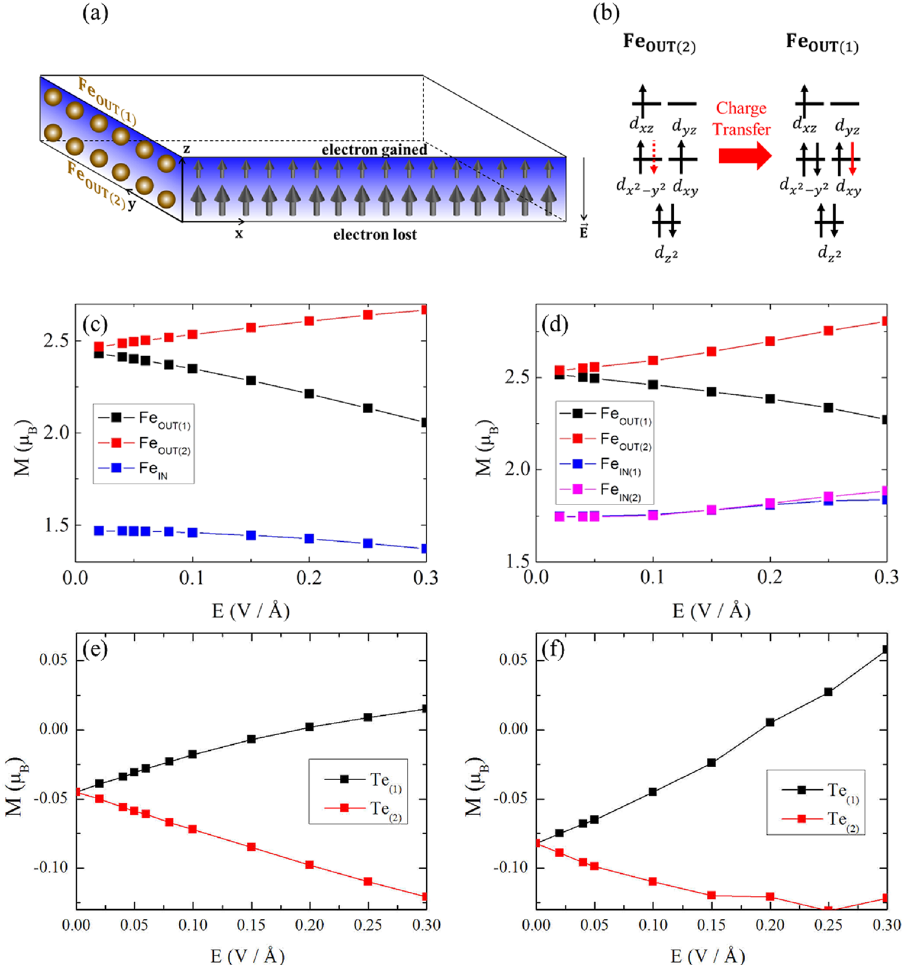
Figure 2. ( a ) Schematic figure of electric field effect on monolayer FGTs on the spin moments of each side of the layer, based on ( b ) the analysis on the relation between net spin moment and the number of electrons for crystal field splitting in case of outer Fe atoms in d 6 occupation. ( c , d ) shows the electric field dependence of the magnetic moments of Fe atoms in Fe 3 GeTe 2 and Fe 4 GeTe 2 respectively, which agree to the expectation in ( b ). ( e , f ) shows the electric field dependence of the magnetic moments of Te atoms in Fe 3 GeTe 2 and Fe 4 GeTe 2 respectively, showing the strong antiferromagnetic interaction and hybridizations between Te atoms and their adjacent Fe